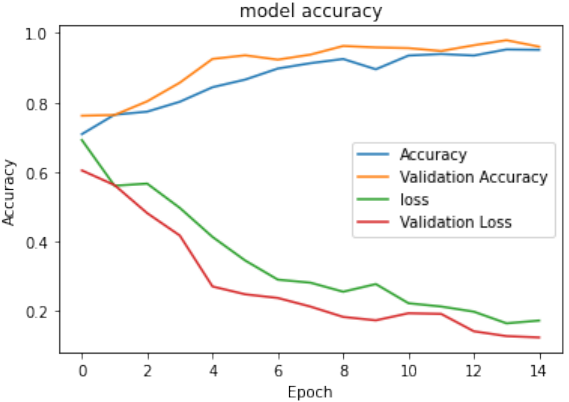
Figure 9. Summary of the VGG19 model classification